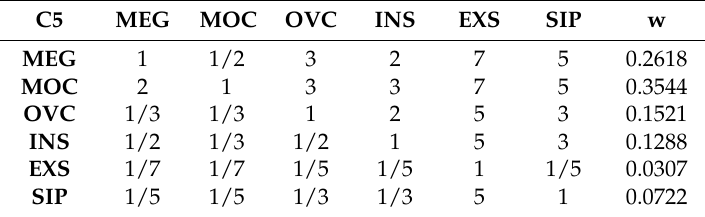
Table 8. Comparison of the six alternatives with regards to ease of operation